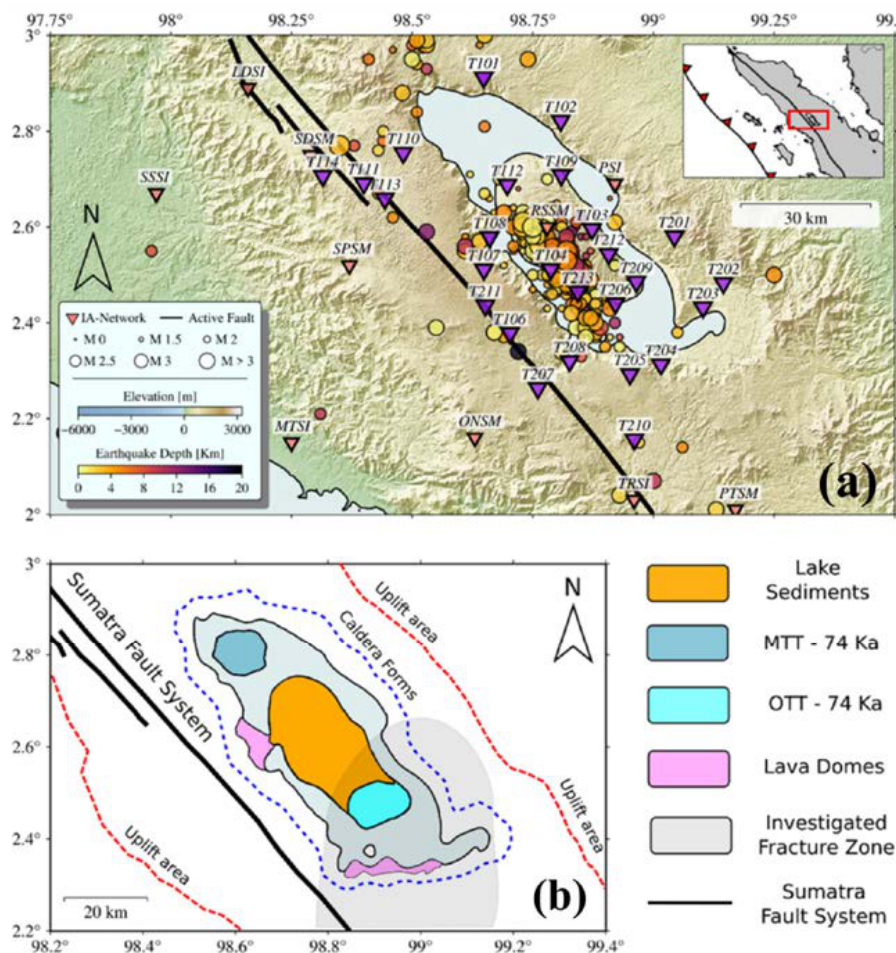
Fig. 2: (a) The seismicity map of the Toba area maps the swarm activities mostly located at Samosir Island and distributed in the NW–SE direction parallel with the Sumatra fault system (Chesner 2012). The seismometer for recording the seismic waveforms is divided into two types, temporary (purple triangle) and permanent (red triangle). (b) The local geological map of Toba features the lake sediments as the dominant geological unit. The three eruptions make a different rock age with old Toba tuffs (OTT)—840 ka, middle Toba tuffs (MTT)—500 ka, and young Toba tuffs (YTT)—74 ka.